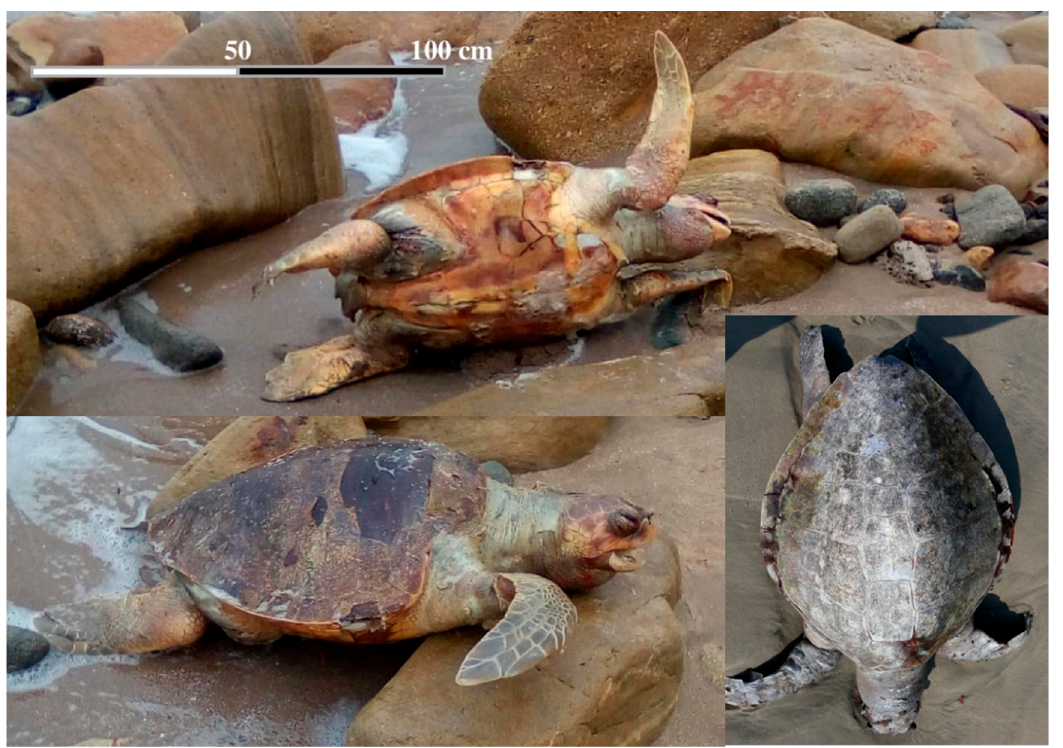
Figure 2. Bycatch and death of olive ridley ( L. olivacea ) sea turtles during fishing activities reported in Bahía de Caráquez-Ecuador (Photo by Lenin